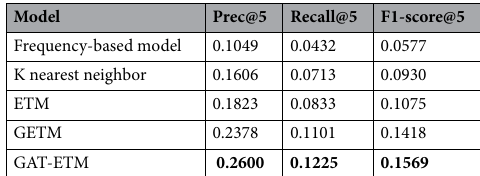
Table 4. Patient-wise imputation measurement. The best score for each metric are in [bold].